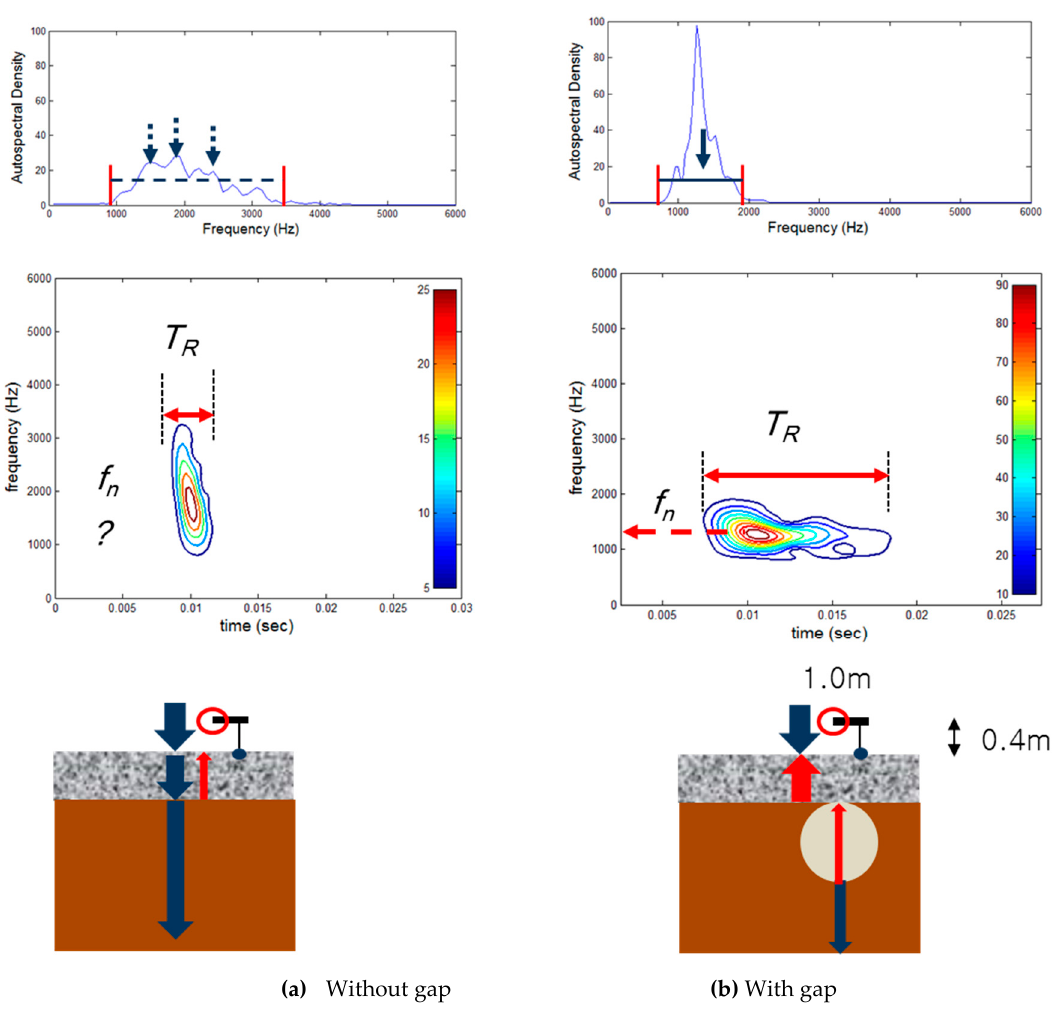
Figure 15. Leaky Rayleigh acoustic waves detected in the air transmitted from the model concrete surface in the field. ( a ) Without gap. ( b ) With gap.